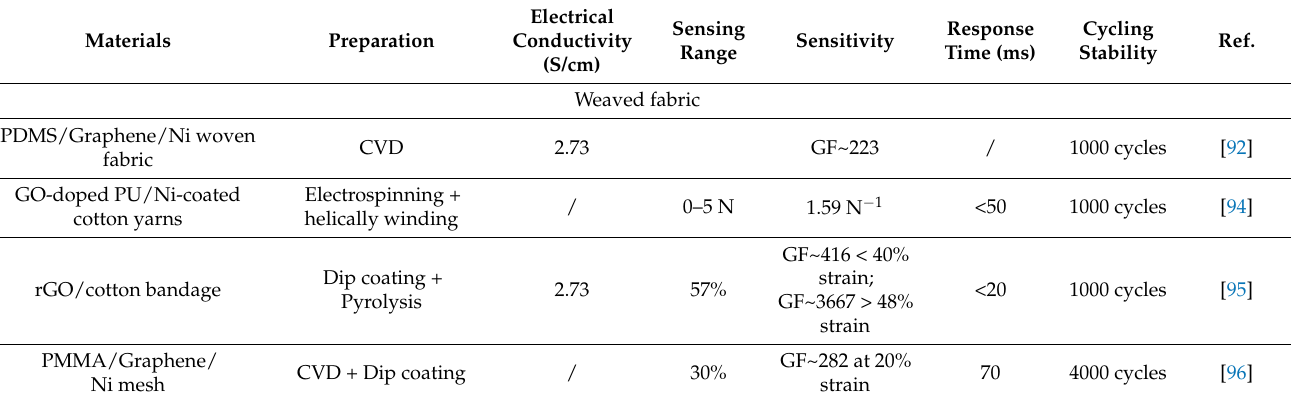
Figure 13. ( a ) Illustration of preparation of cellulose nanocrystal- and graphene-coated non-woven fabric composite sensor; ( b ) SEM images showing the micro-cracking sensing mechanism of the stain sensor; Reprinted with permission from Ref. [101]. 2019, Elsevier. ( c ) schematic of attachment of BSA and GO on non-woven fabric fibers and corresponding sensing process; Reprinted with permission from Ref. [102]. 2020, American Chemical Society, and ( d ) illustration of preparation of capacitive-type wearable strain sensor. Reprinted with permission from Ref. [103]. 2019, Wiley-WCH. Table 3. Brief summary of the fabric patterns and corresponding output performance of textile-based sensors.